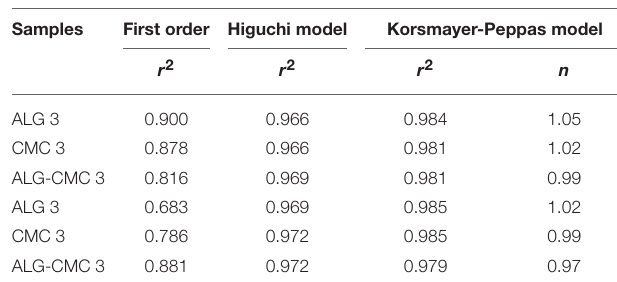
TABLE 2 | The values of correlation coefficient ( r 2 ) and release exponent (n) calculated from different kinetic models for DCF and LID loaded